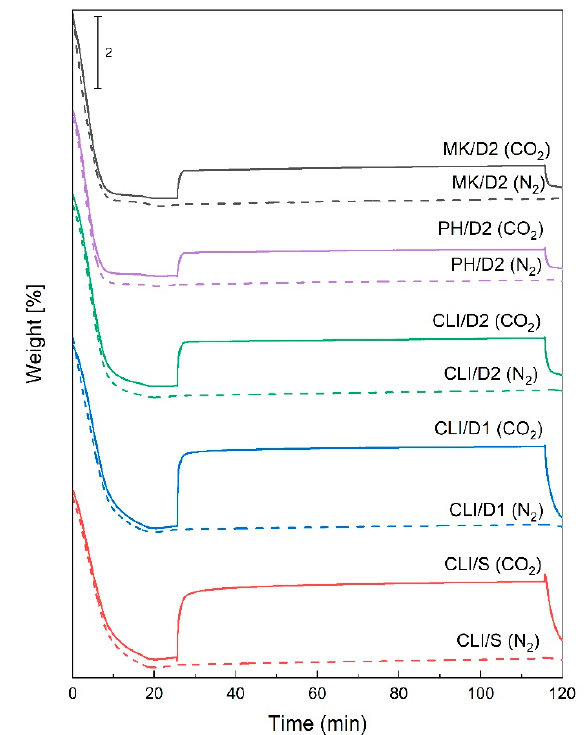
Figure 7. CO ₂ sorption curves of clinoptilolite determined by TGA. Figure 7. CO 2 sorption curves of clinoptilolite determined by